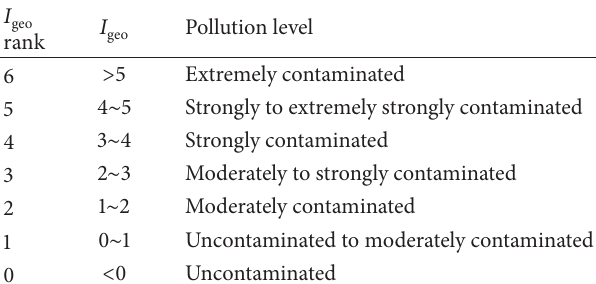
Table 2: Description of sediment quality.